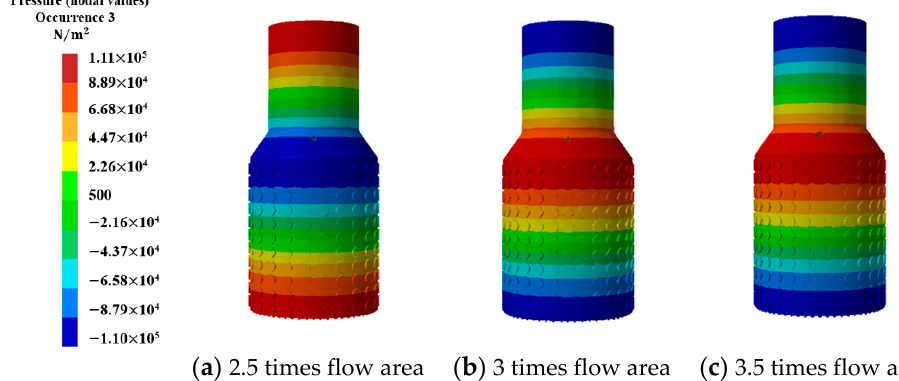
Figure 21. Second-order acoustic cavity modality.